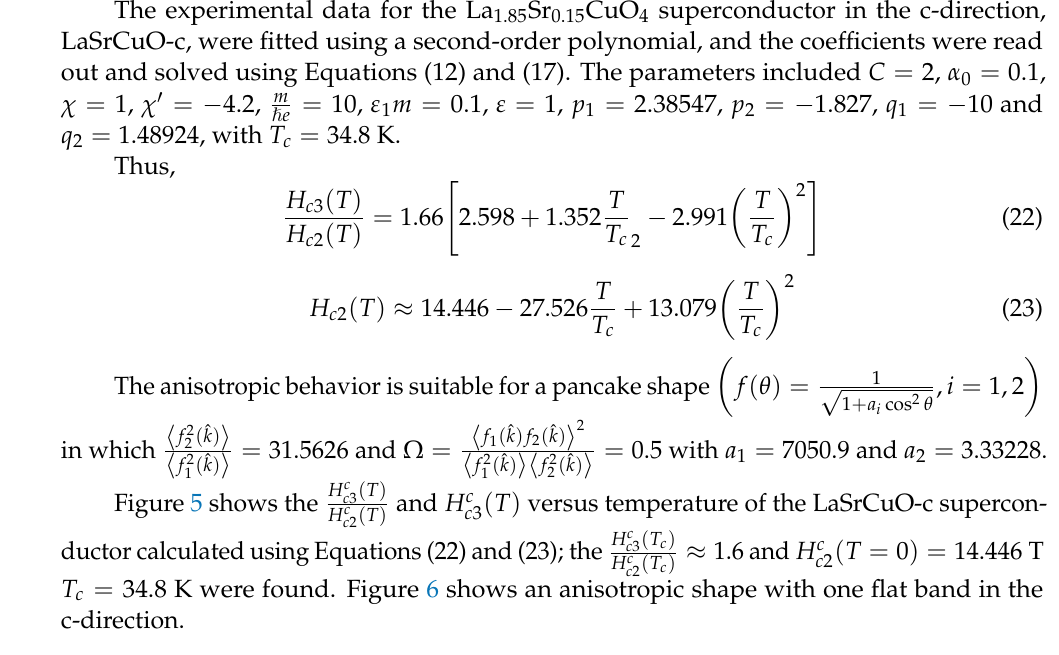
Figure 5. The and )(